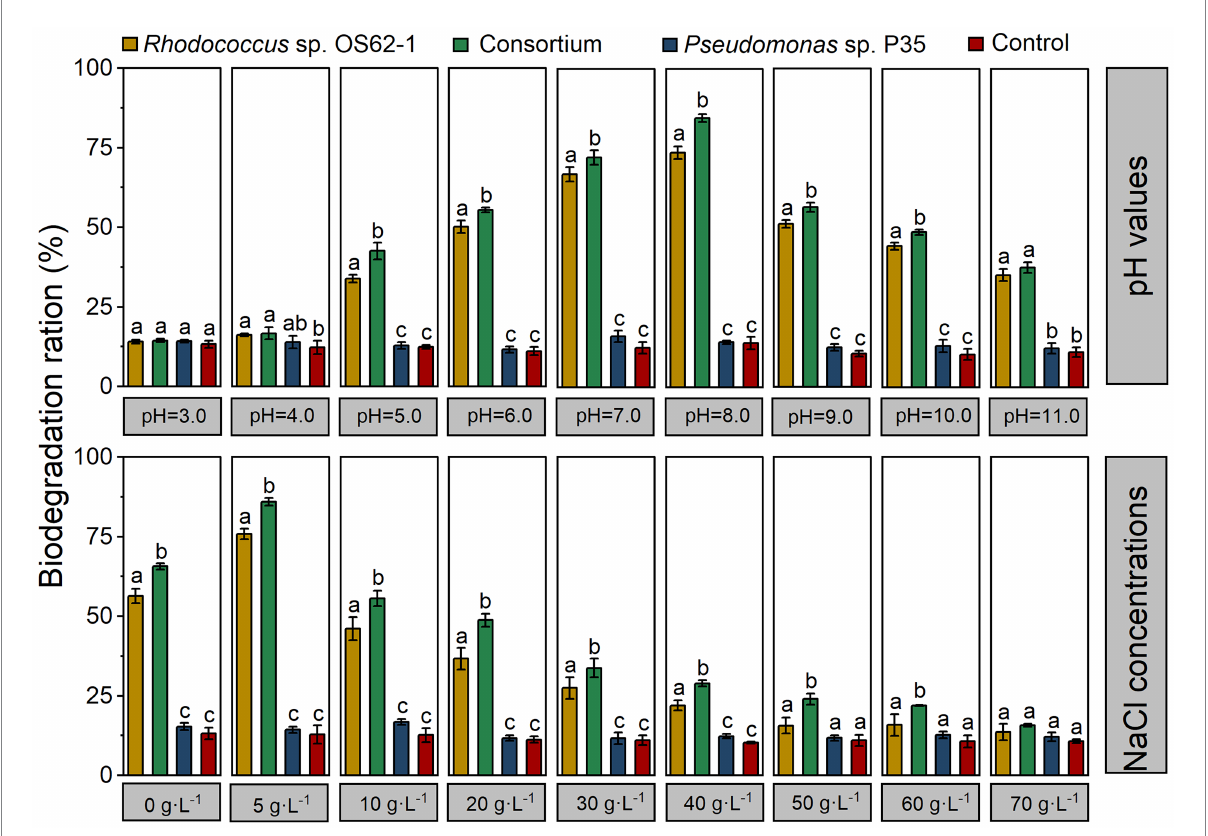
FIGURE 7 The degradation efficiency of crude oil by the single strain and consortium under different pH values and NaCl concentrations in 7 days. Groups sharing different letters (a, b, c) indicate significant differences between two treatments by one-way ANOVA test ( p <